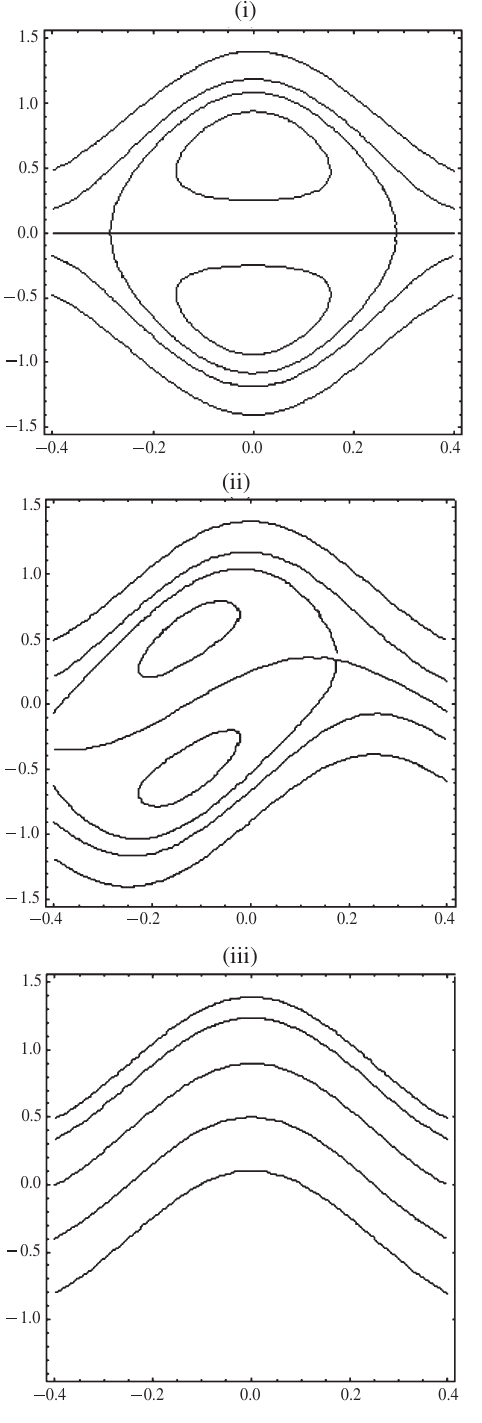
Fig. 11. Streamlines for a = b =0.5; d =1. Q = 1 . 4 and β = 0 . 3 for different γ (i) γ = 0, (ii) γ = π/ 2, (iii) γ = π